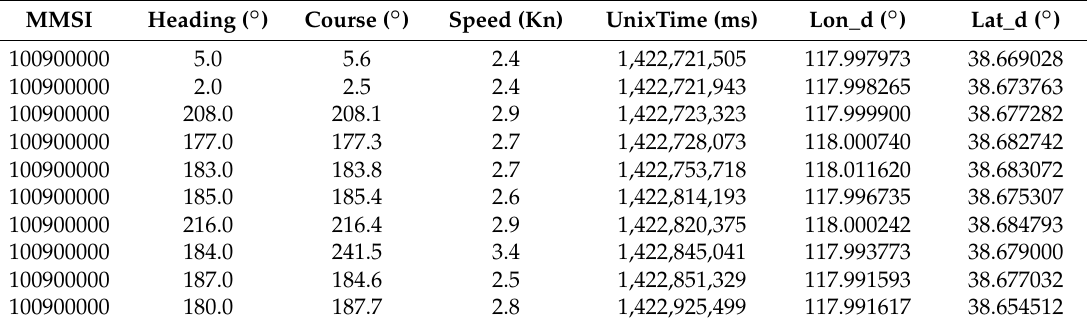
Figure 9. Automatic identification system (AIS) data diagram for the Tianjin Port area in 2015. Table 1. Automatic identification system (AIS) data structure storage. MMSI, Maritime Mobile Service Identity.